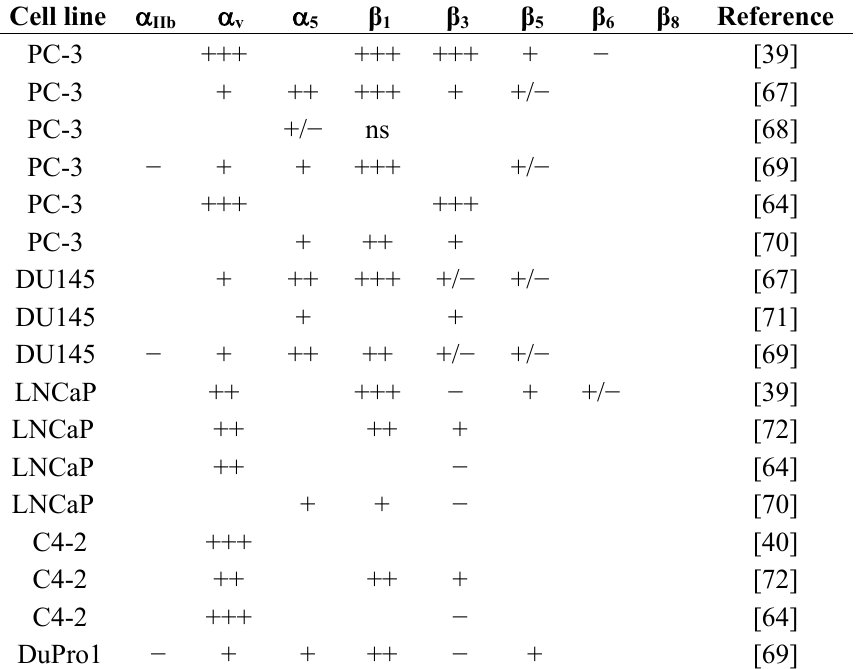
Table 4. RGD-binding integrin subunit expression on the surface of prostate cancer cell lines. Key: +++ very high; ++ high; + moderate; +/− low; − negative; blank not tested; ns expressed but level not